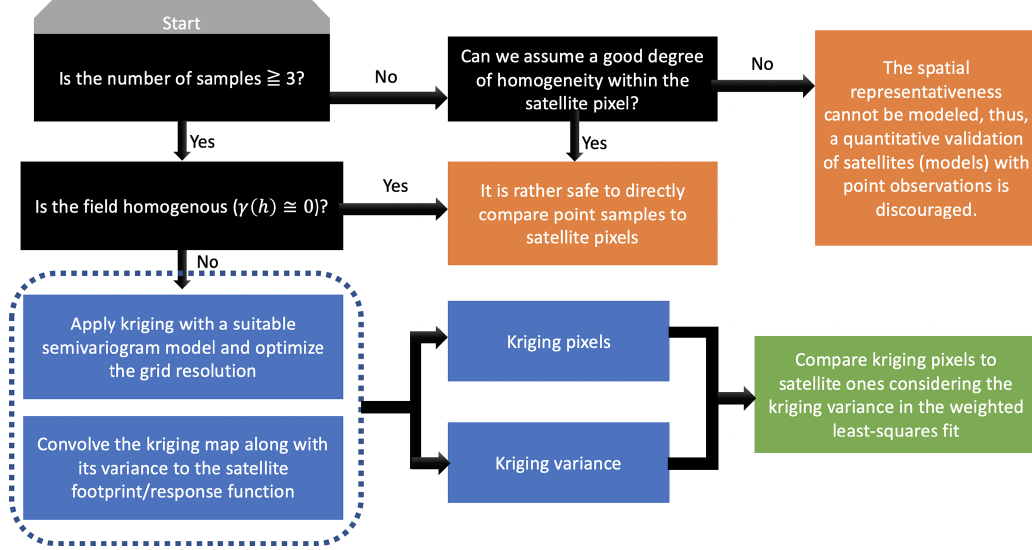
Figure 9. The proposed roadmap for transforming pointwise measurements to gridded data in satellite (model)